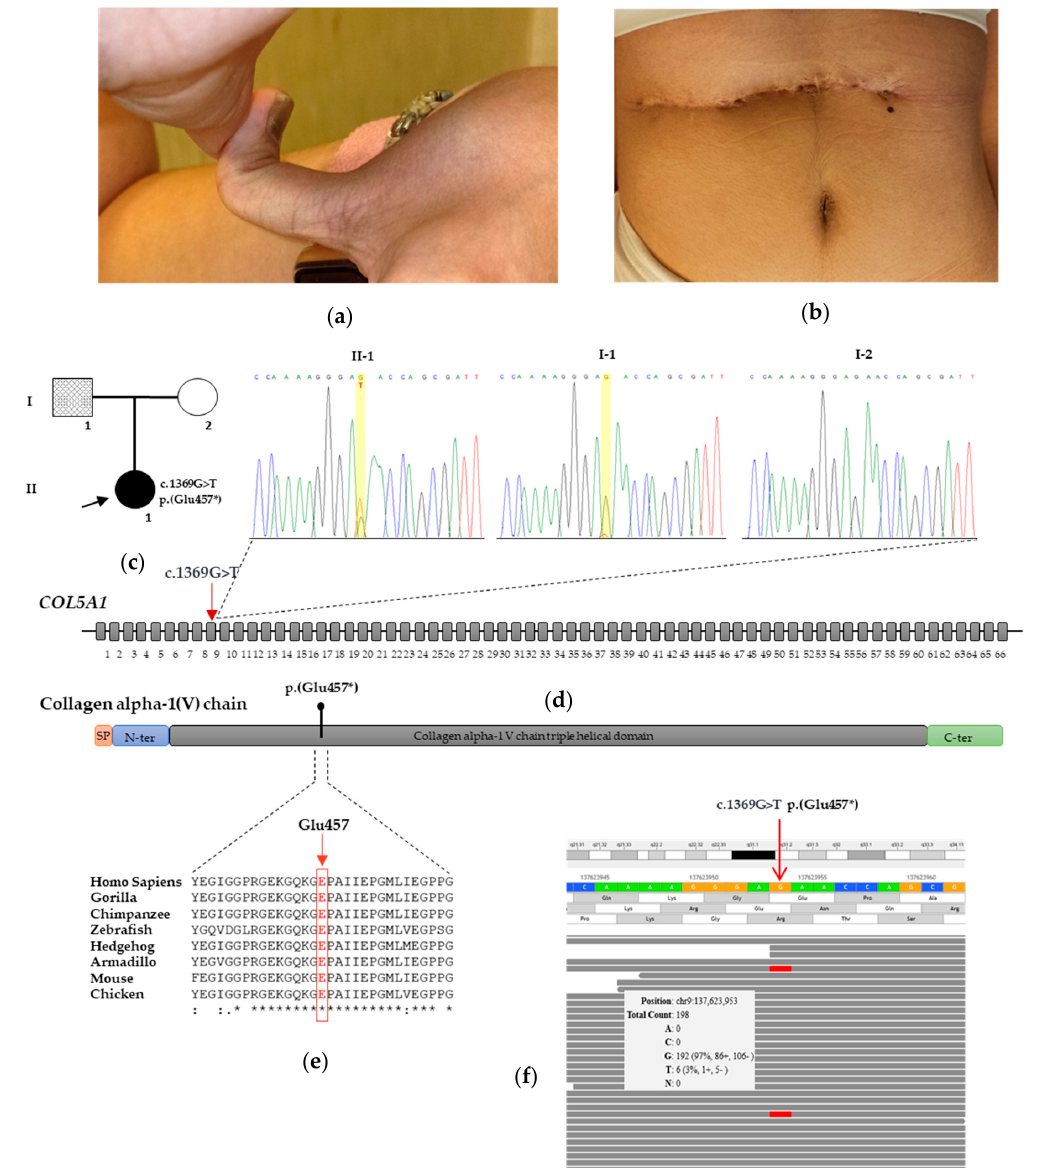
Figure 1. Clinical aspects and molecular findings. ( a ) Distal phalanx hyperextension of the thumb in the proband. ( b ) Dystrophic post-surgical scarring formation in the proband. ( c ) Pedigree of the studied family with parental mosaicism; the affected heterozygous proband is indicated with a filled symbol, and the individual with mosaicism is indicated by a hatched symbol. ( d ) Electropherogram showing DNA sequencing of the proband carrying c.1369G>T, p.(Glu457*) in exon 9 of COL5A1 and her unaffected parents. In the middle of the panel, there is a schematic representation of the COL5A1 gene that shows the heterozygous c.1369G>T variant. A yellow bar indicates the affected nucleotide. The arrow indicates the germline variant in the proband. The identified variant is also put in a gene and protein context. In the middle, the coding regions are in grey; the black line represents the intron regions that are not to scale. In the lower part is a schematic diagram of the collagen type V alpha-1 chain protein: the signal peptide is in red, and N-terminal and C-terminal propeptide domains are in blue and green, respectively. ( e ) Alignment of the amino acid sequence of the collagen type V alpha-1 chain region, including the residue p. Glu457 among several species, was generated by Clustal Omega. ( f ) Genomebrowser view from the Alissa software output. The grey window shows that the COL5A1 c.1369G>T allele is present in 3% of the reads in the father’s blood